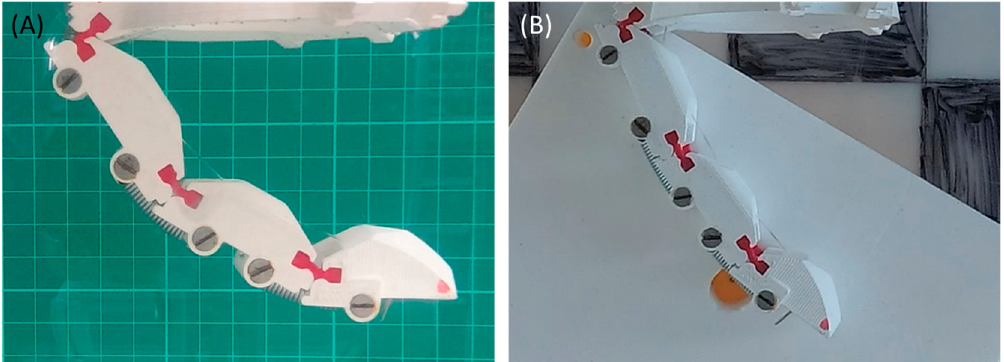
Figure 7. Position test setup in water ( A ) and on PTFE ( B ).